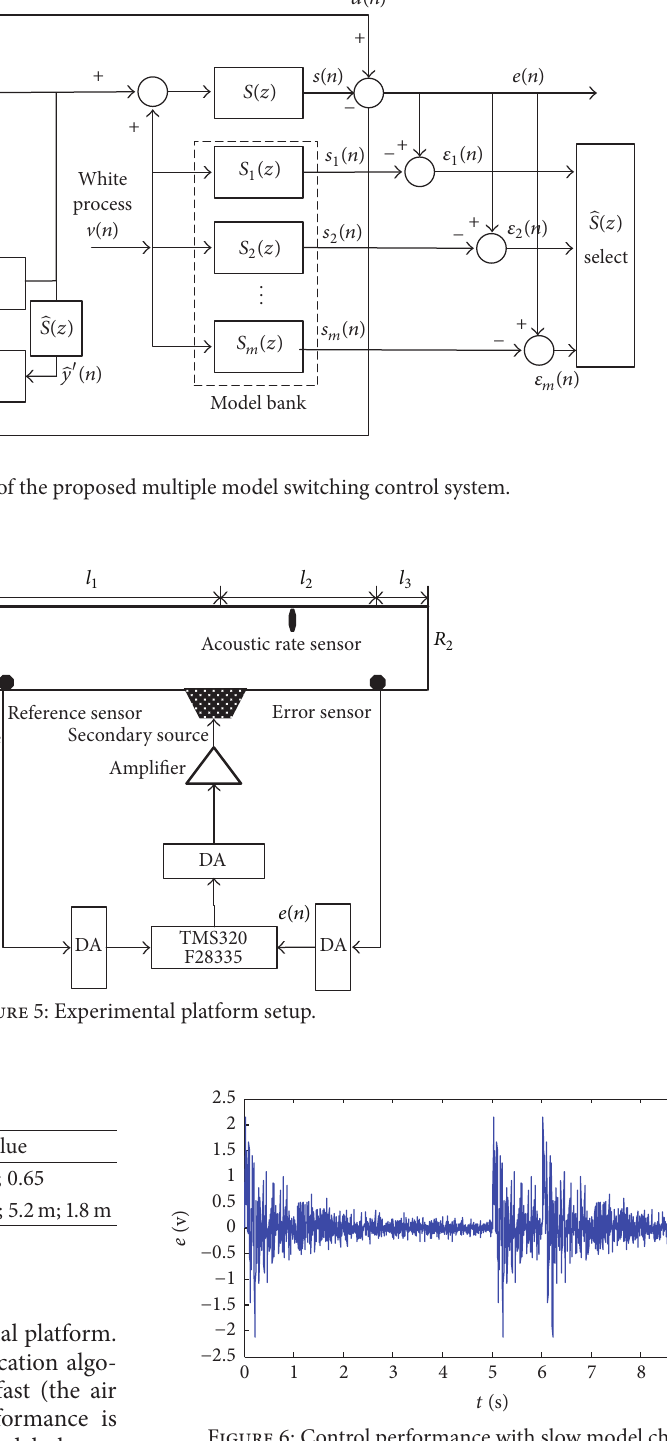
Figure 6: Control performance with slow model